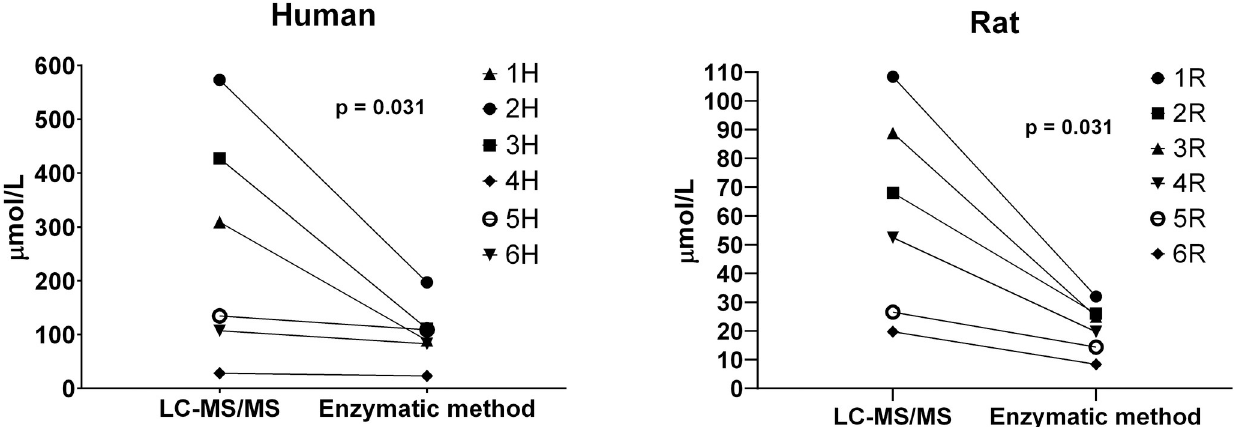
Fig 2. Enzymatic method underestimates total BA concentration in cholestatic serum samples with atypical BA spectra. Concentrations of total BAs in six cholestatic human sera and six cholestatic rat sera were determined using an enzymatic kit (triplicates) and LC-MS/MS (single measurement).